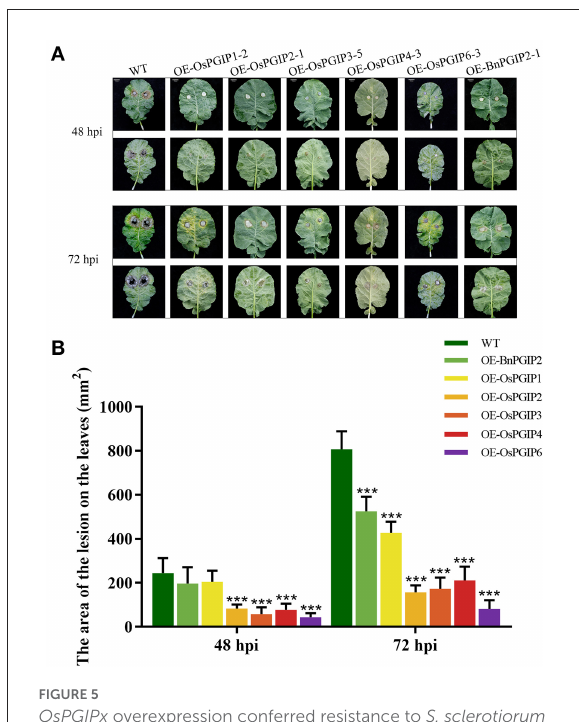
FIGURE5 OsPGIPx overexpression conferred resistance to S. sclerotiorum in detached leaves inoculation. (A) Detached leaves of overexpression lines and non-transgenic line inoculated with 10-mm agar plugs of S. sclerotiorum hyphae at 22 ◦ C. Images were taken at 48 and 72h post-inoculation (hpi). Scale bars are 20mm. (B) Lesion on detached leaves at 48 and 72 hpi. Significant differences were showed by: *** P < 0.001. Error bars indicate SE based on five independent biological replicates.